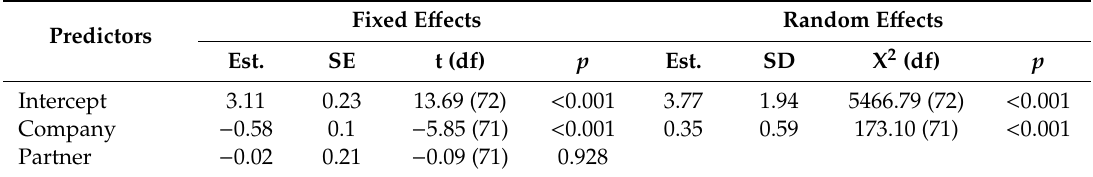
Table A1. Parameter estimates for multilevel model A.1.